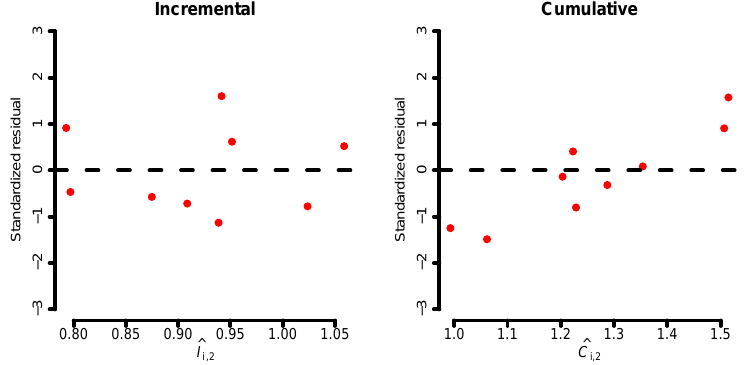
Figure 1. Standardized residuals for the second development year for the incremental model (left) and for the cumulative model (right). Fitted values are in